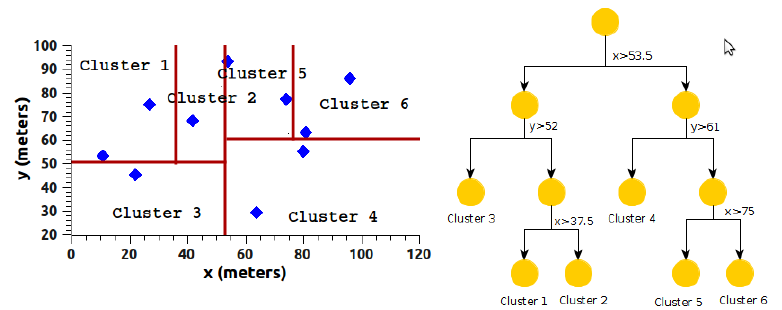
Figure 7. Clustering using the k-d tree